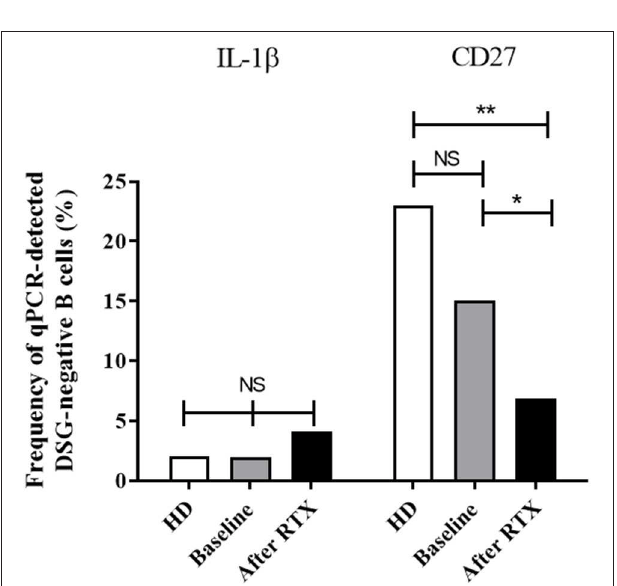
FIGURE 4 | Frequency of cells with detectable mRNA encoding for the IL-1 β and CD27 genes in one-cell sorted desmoglein-negative B cells from healthy donors (white columns, n = 69 cells) and pemphigus patients at baseline (gray columns, n = 201 cells) and after rituximab treatment (black columns, n = 106 cells). Frequencies were compared using the Fisher’s exact